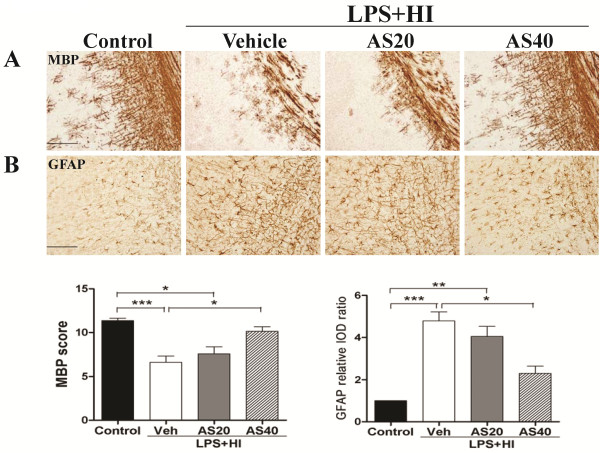
Pharmacological inhibition of c-Jun N-terminal kinase (JNK) activity using AS601245 significantly attenuated white matter injury. AS601245 (40 mg/kg) (n = 8) but not AS601245 (20 mg/kg) (n = 8) treatment had significantly higher myelin basic protein (MBP) (A) and lower glial fibrillary acidic protein (GFAP) (B) expression in the white matter than vehicle (n = 10) on P11 after lipopolysaccharide (LPS)-sensitized hypoxic-ischemia (HI) on P2. Scale bar = 200 μm in (A), 100 μm in (B). Values are means ± SEM. ***P < 0.001, **P < 0.01, *P < 0.05.